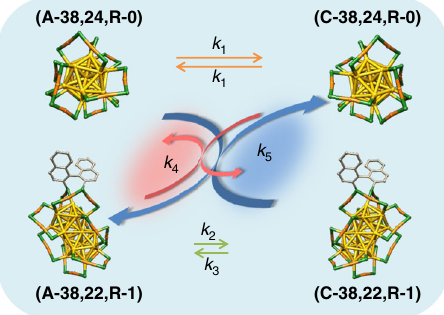
Fig. 5 Schematics of the reactions, which are considedred in the dynamic system. The symbols k 1 to k 5 stand for the rate constant of the